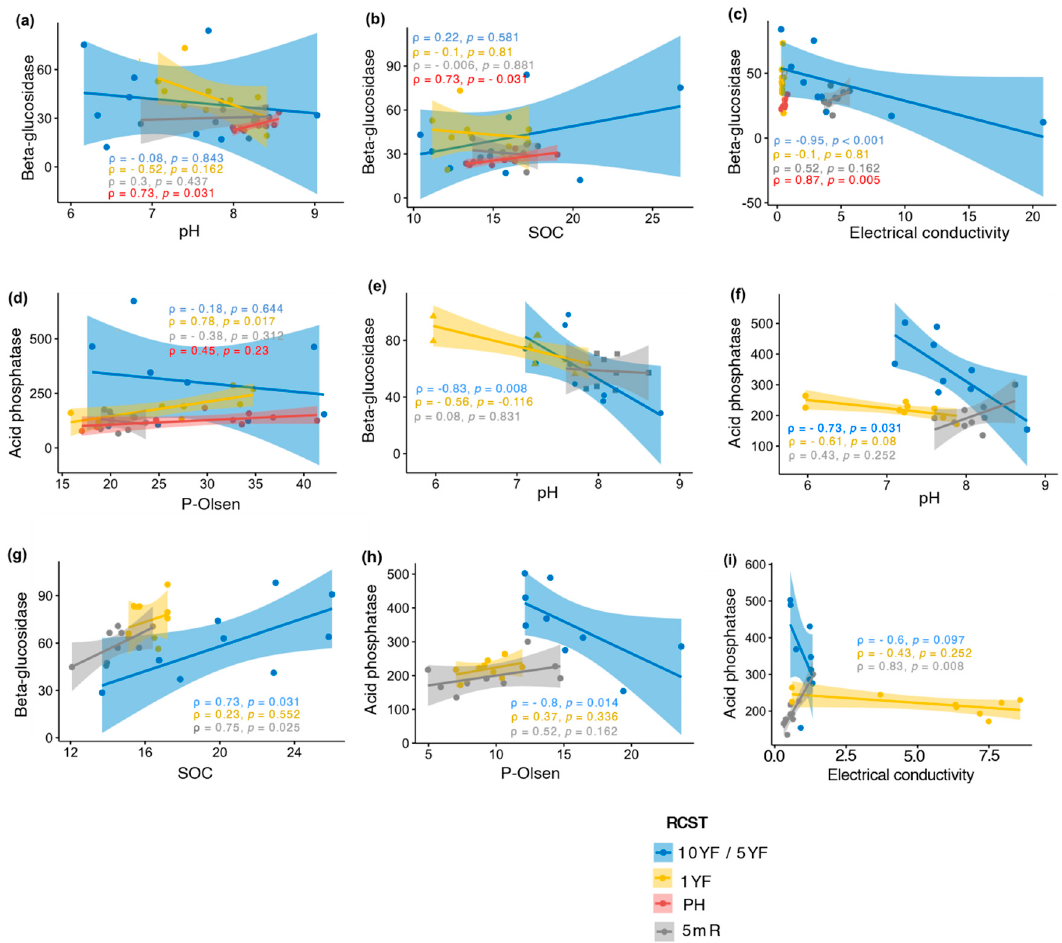
Figure 1. Relationship between enzyme activities and soil chemical properties in Umbeluzi ( a – d ) and Chokwe ( e – i ). Rho ( ρ ) and p-values embedded in the plot are rounded off to 2 d.p. and 3 d.p., respectively. 10YF, ten years fallow; 5YF, five years fallow; 1YF, one-year fallow; PH, postharvest; 5mR, five months off-season time point. “10YF/5YF” denotes fallow fields in Umbeluzi or Chokwe, respectively. SOC, Soil organic carbon.